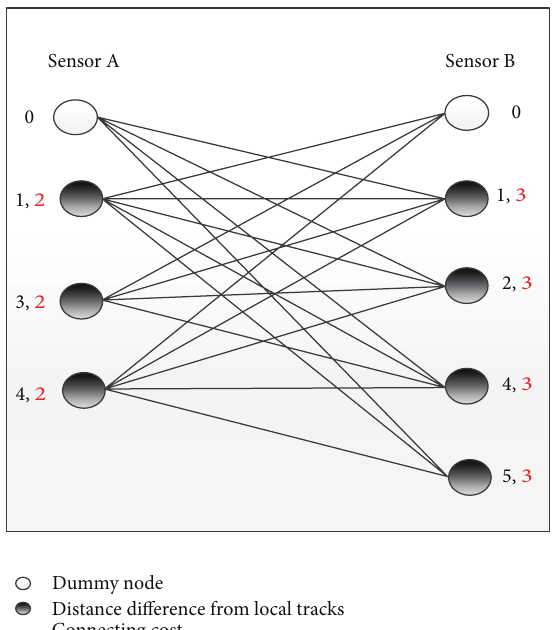
Figure 4: Graphical representation of 2D assignment subproblem to compute the cost 𝑐 23